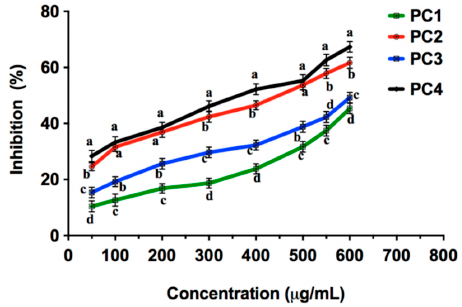
Figure 2. AChE inhibitory activity of different cultivars of persimmon seeds; Values in the different lower-case letters are significantly different at p < 0.05 ( n = 3).